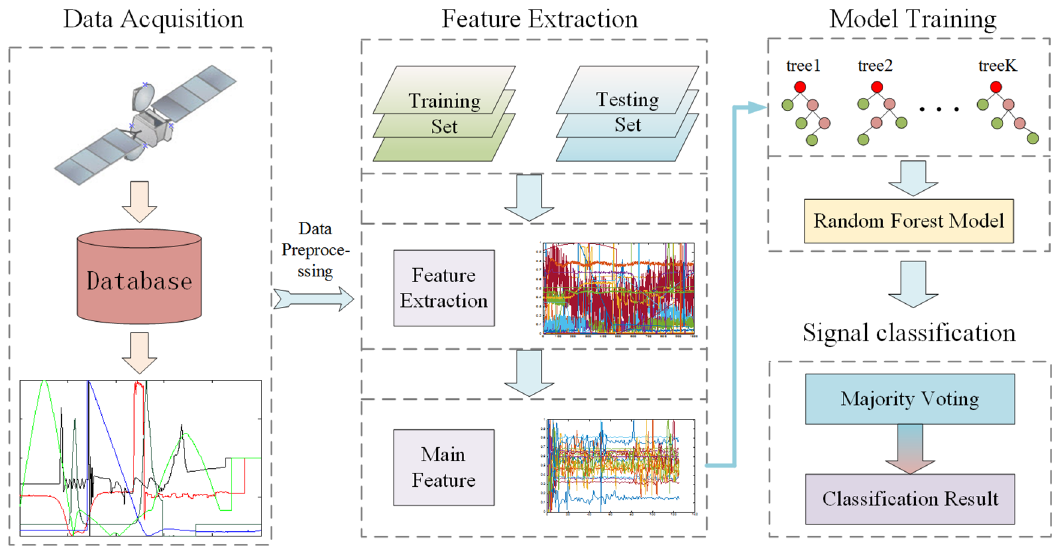
Fig 1. The flow chart of algorithm by this article. The process of the algorithmmodel consists of three parts: data acquisitionusing wavelet denoising,feature extraction using DNN method, and signal recognitionusing random forest. The flow chart of the typical test data sample and a typical standard data sample obtainedfrom the electrical characteristics of the spacecraft are shown in the